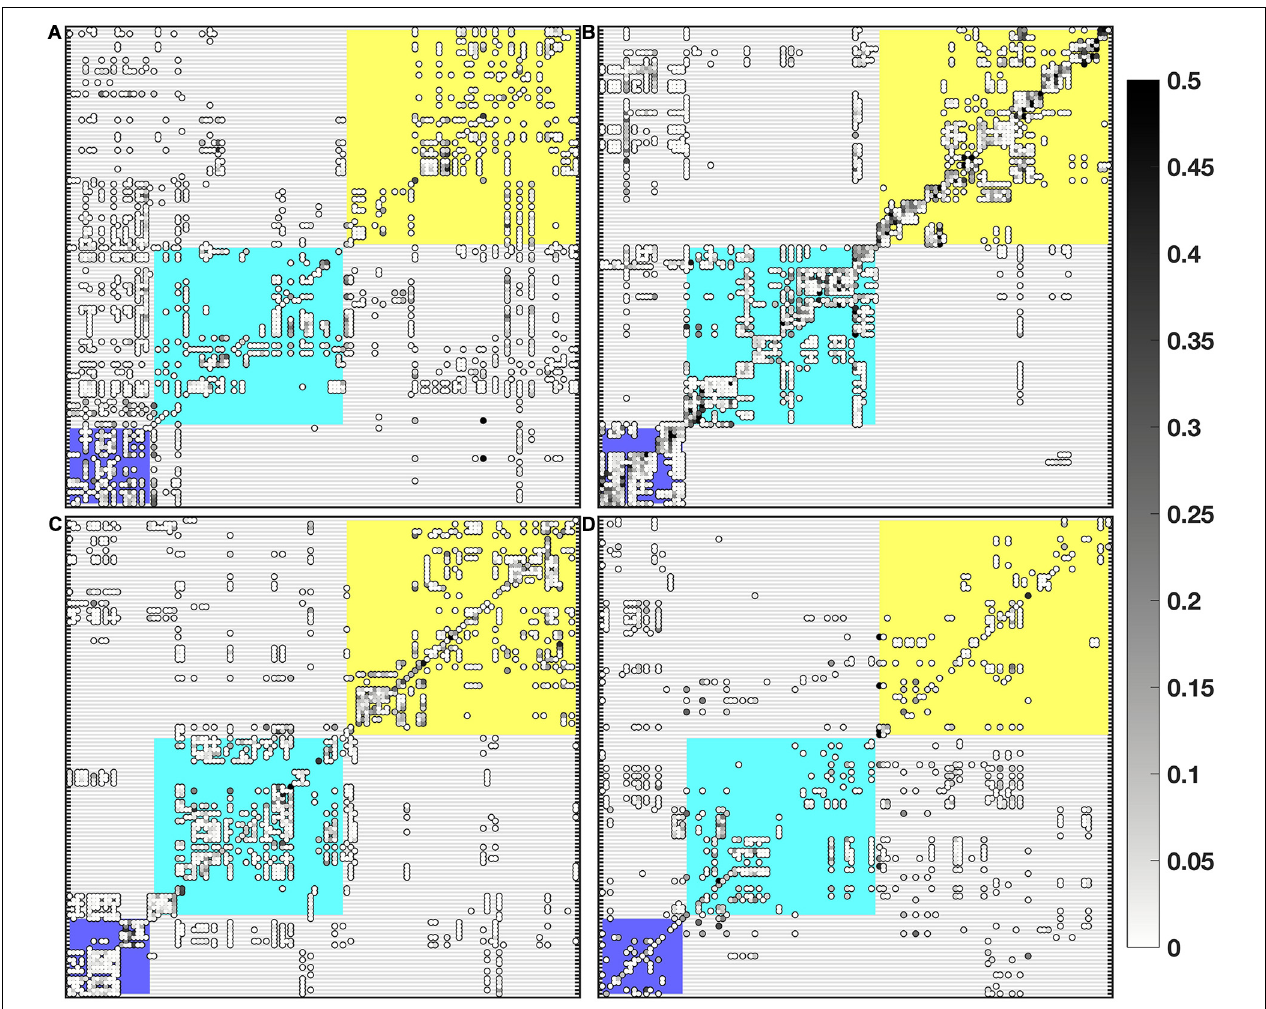
FIGURE 4 | Settlement matrices for seasonal runs: (A) NEM, (B) dry-transition, (C) SWM, and (D) early NEM. Nodes are arranged according to the dry-transition coherent regions, with color-coded rectangles corresponding to the three marine provinces from Figure 2 . The color overlay of markers within settlement matrices represents settlement probability values and uses the colormap gray from the cmocean toolbox (Thyng et al., 2016).